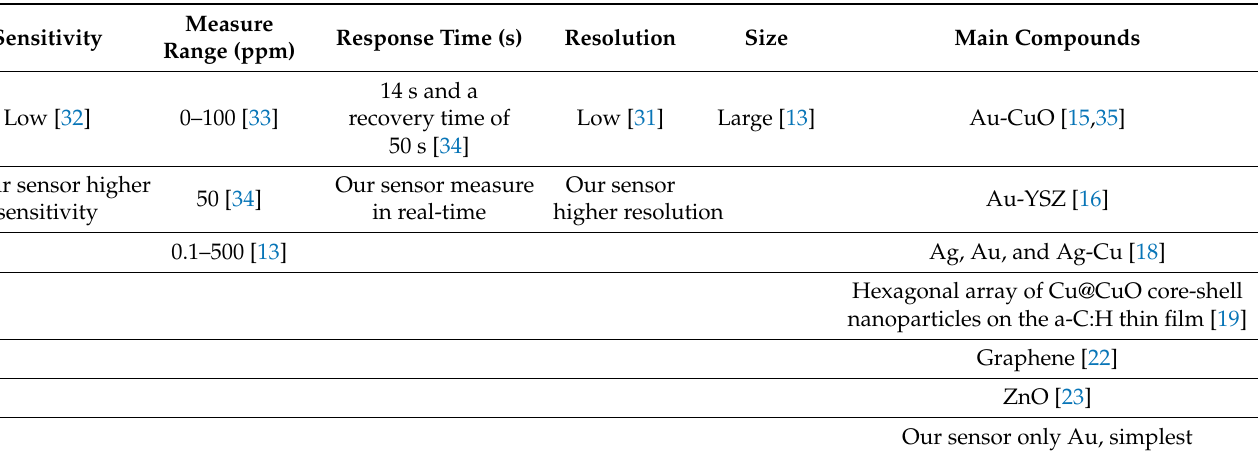
Table 2. Summary of the comparison/discussion of the CO sensors with